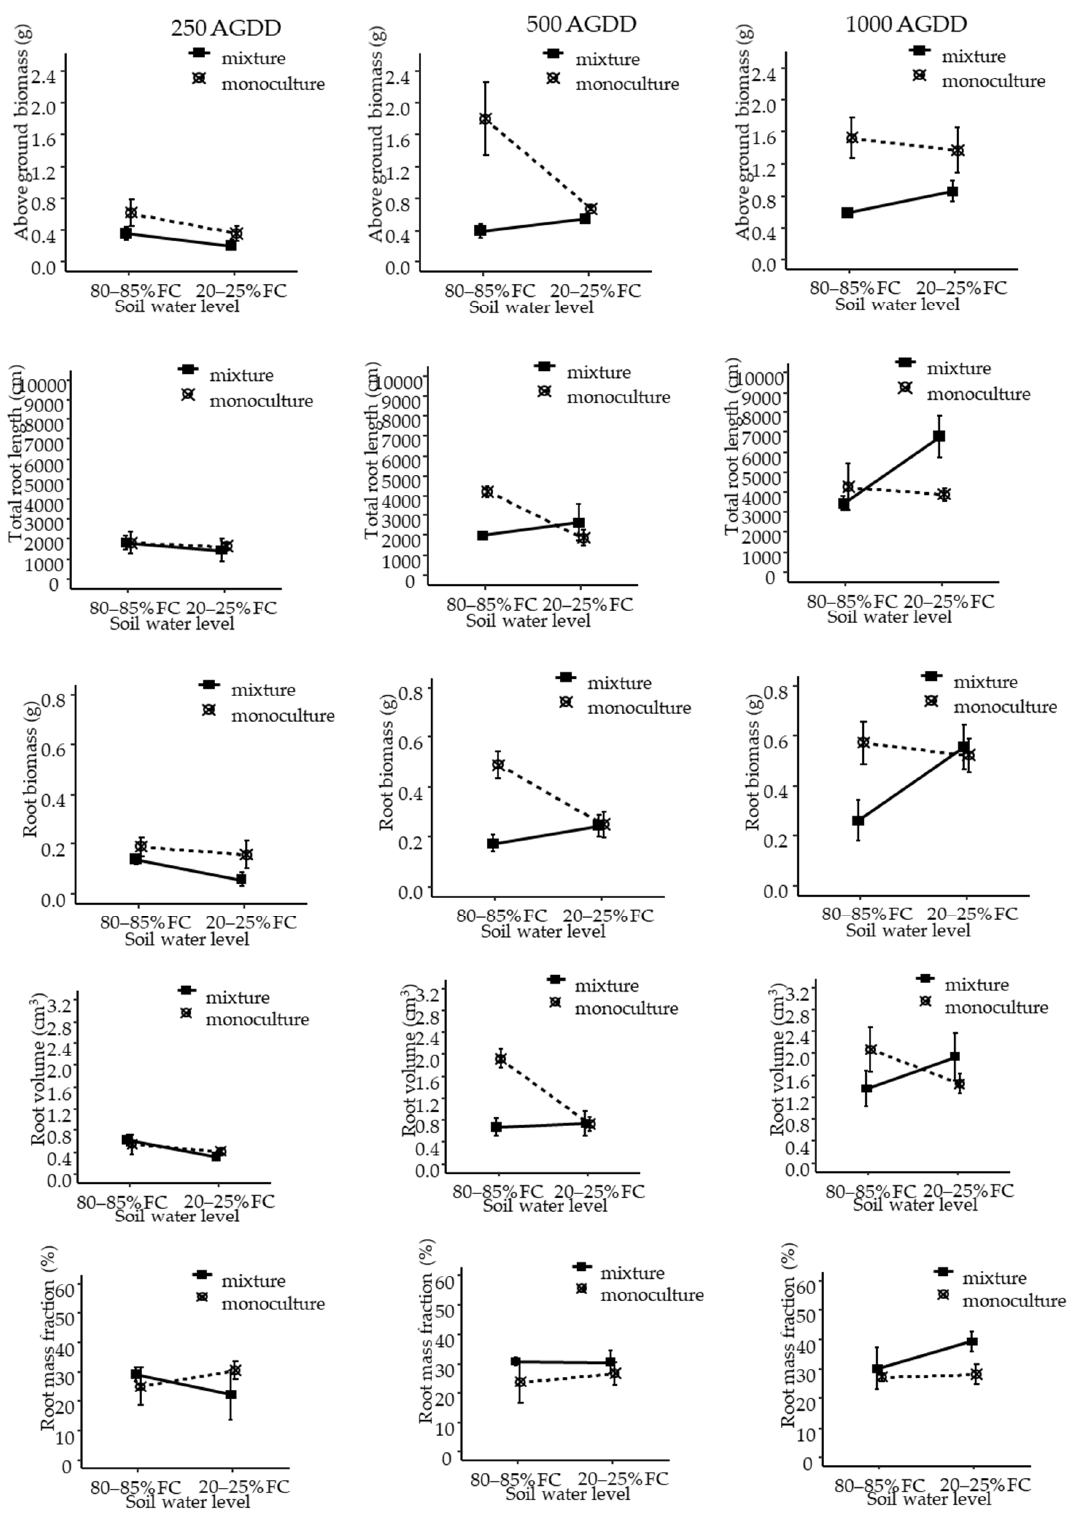
Figure 1. Effect of variation in soil water content, from 80–85% of field capacity (FC) to 20–25% FC on Bromus valdivianus morphology grown under two pasture types (monoculture and in a 50/50% mixture with Lolium perenne ), and subjected to three levels of defoliation frequency (250, 500 and 1000 accumulated growing degree days (AGDD)). The first column shows 250 AGDD defoliation treatment, the second 500 AGDD ad the third 1000 AGDD